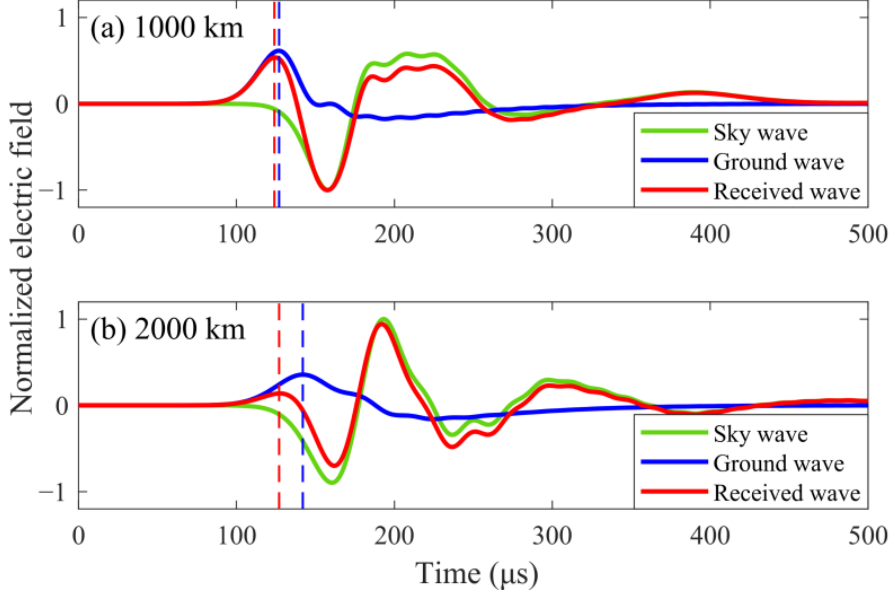
Figure 16. Division of the waveform bank (red solid line) into actual ground wave (blue solid line) and sky wave (green solid line). The red dashed line and blue dashed line represent the peak arrival time of the waveform bank and the actual ground wave, respectively. ( a ) Waveforms received at 1000 km. ( b ) Waveforms received at 2000 km.